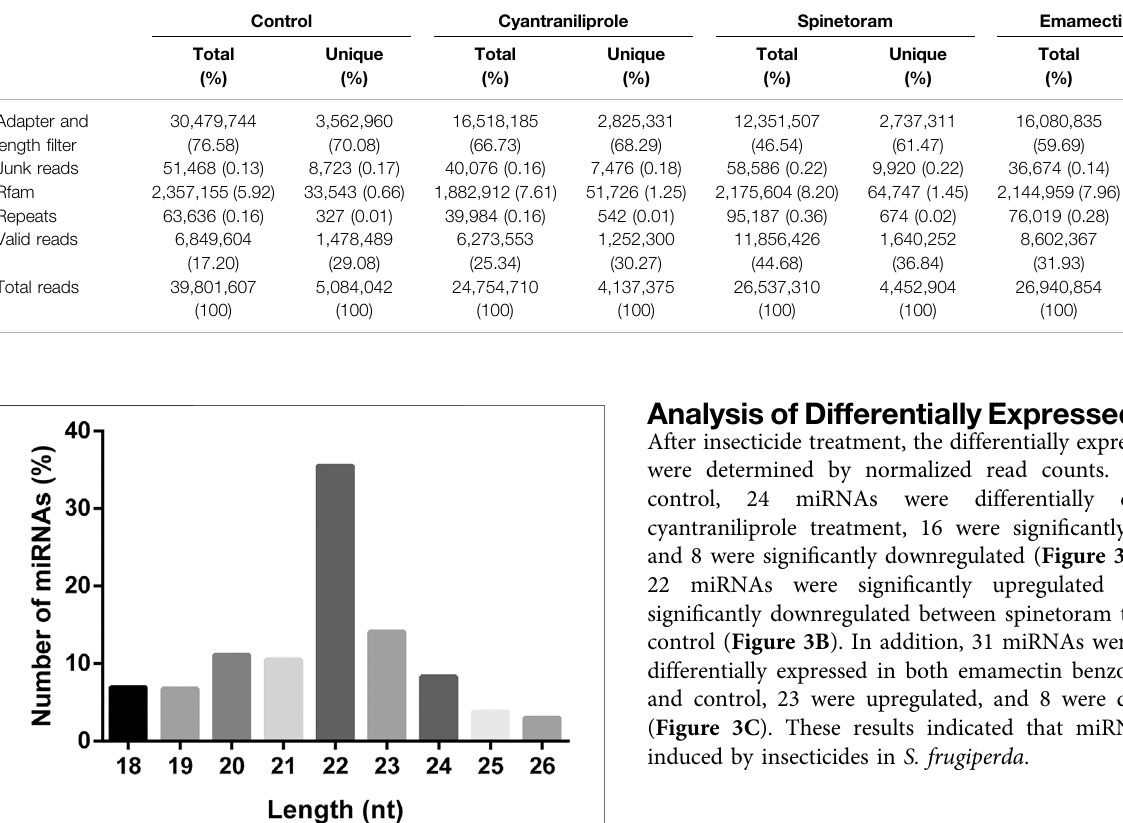
Supplementary Table S3 . The conservative pro fi le of miRNAs in S. frugiperda was explored, and 58 miRNA sequence families were identi fi ed from the miRBase database ( Figure 2A ). miR-1 was the family with the largest number of miRNAs ( Figure 2A ). Furthermore, the frequency of miRNA identi fi ed in S. frugiperda in other insect species was analyzed. Bombyx mori and Manduca sexta shared 61 and 56 of their conserved miRNAs with S. frugiperda , respectively ( Figure 2B ). The sequencing data would greatly expand the number of miRNAs in S. frugiperda .